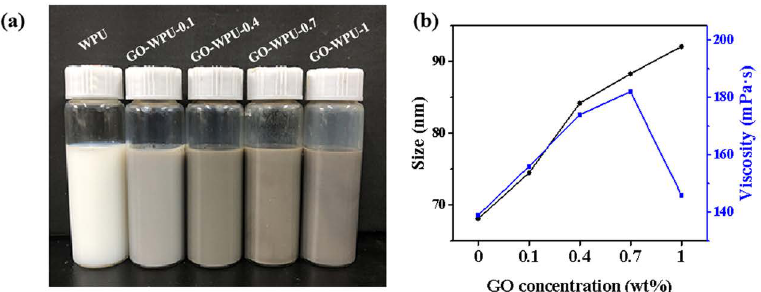
Figure 3. Effect of GO concentration on emulsions. ( a ) Appearance of emulsions after centrifugation; ( b ) particle size and viscosity of emulsions.